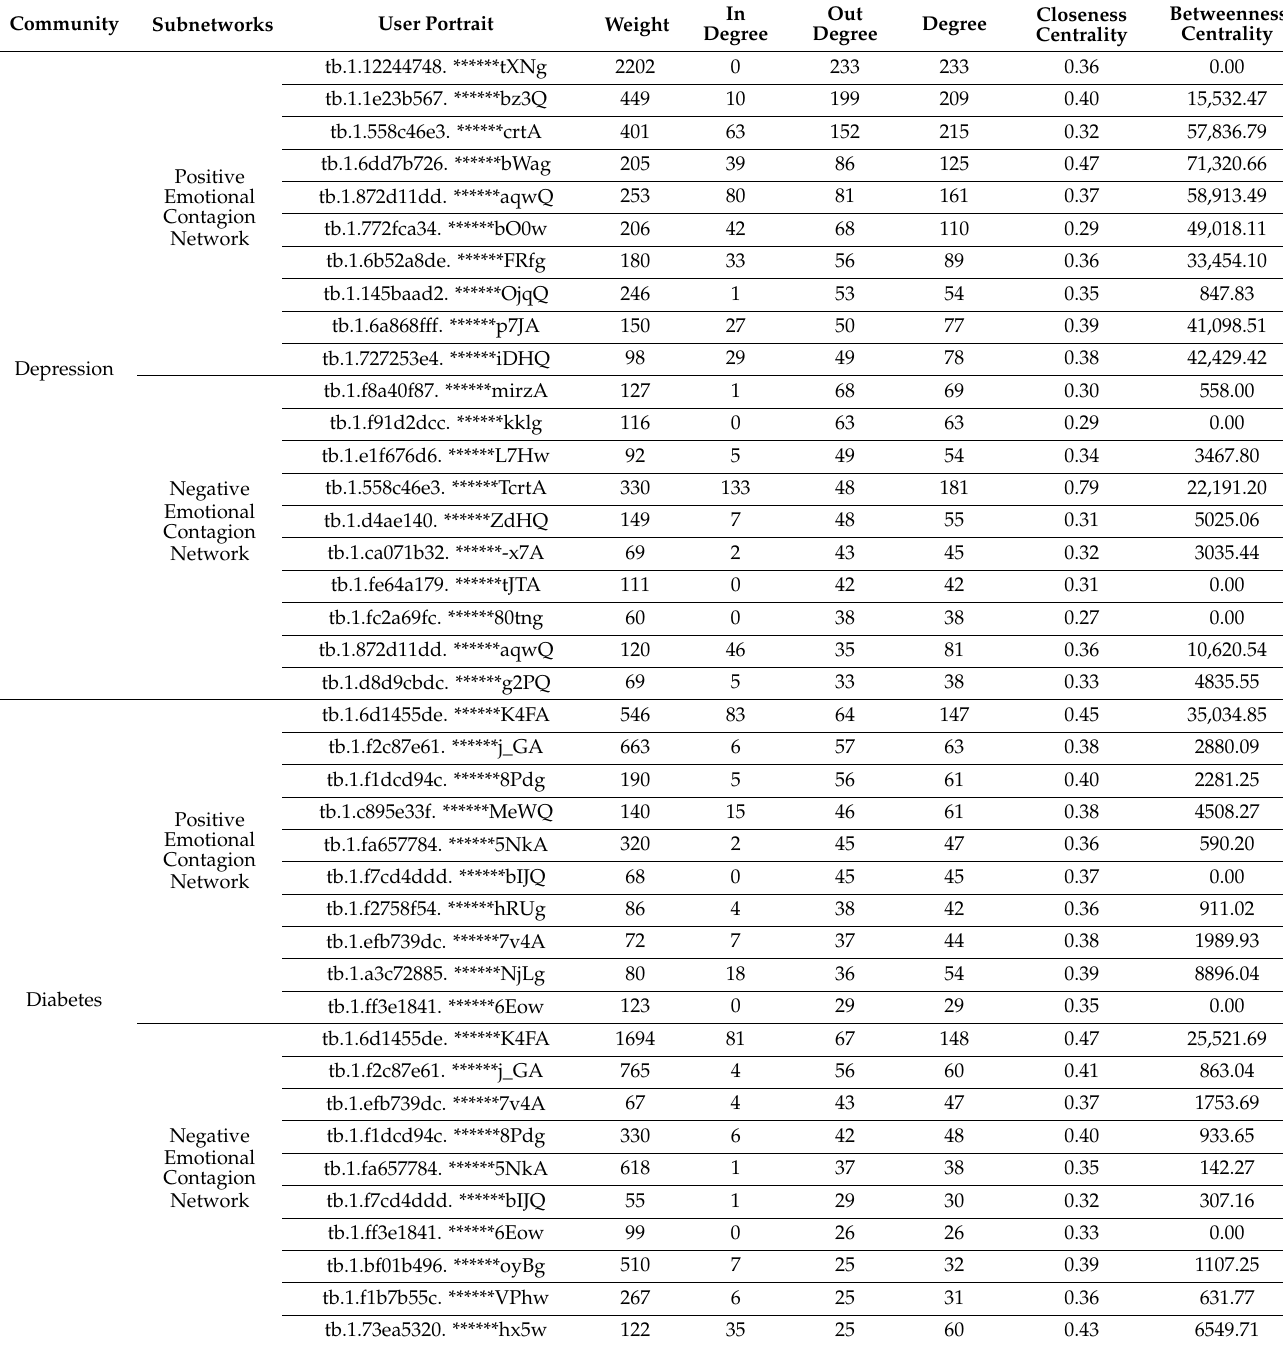
Table A2. Top 10 core uses sorted by out degree in four emotional contagion